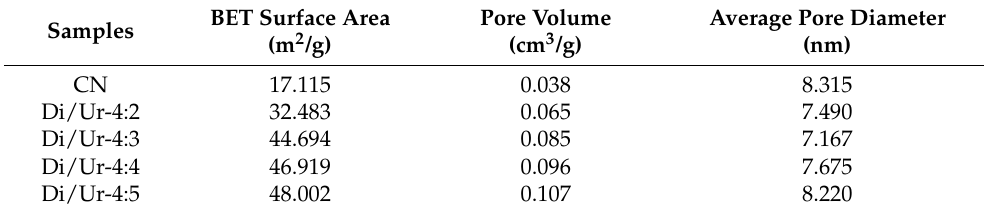
Table 1. BET parameters of g-C 3 N 4 and the obtained Di/Ur samples.